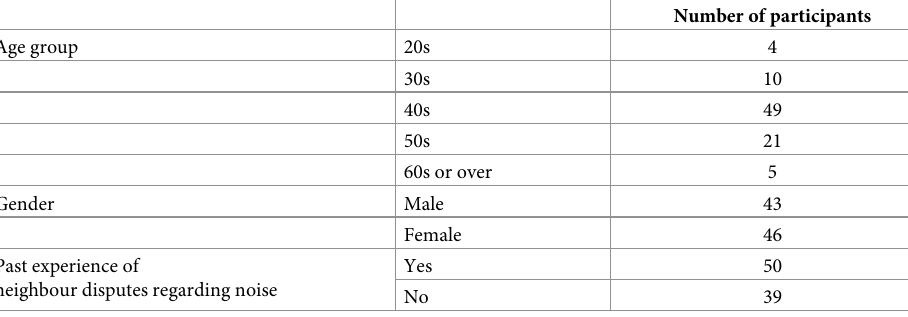
Table 3. Information about the respondents in Survey II ( n =